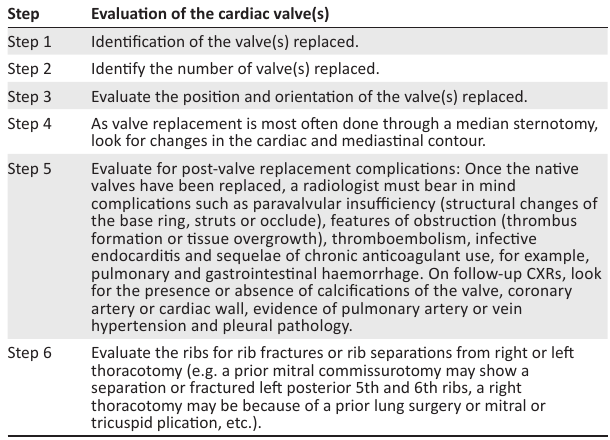
TABLE 4: A stepwise approach for the evaluation of chest radiographs following cardiac valve